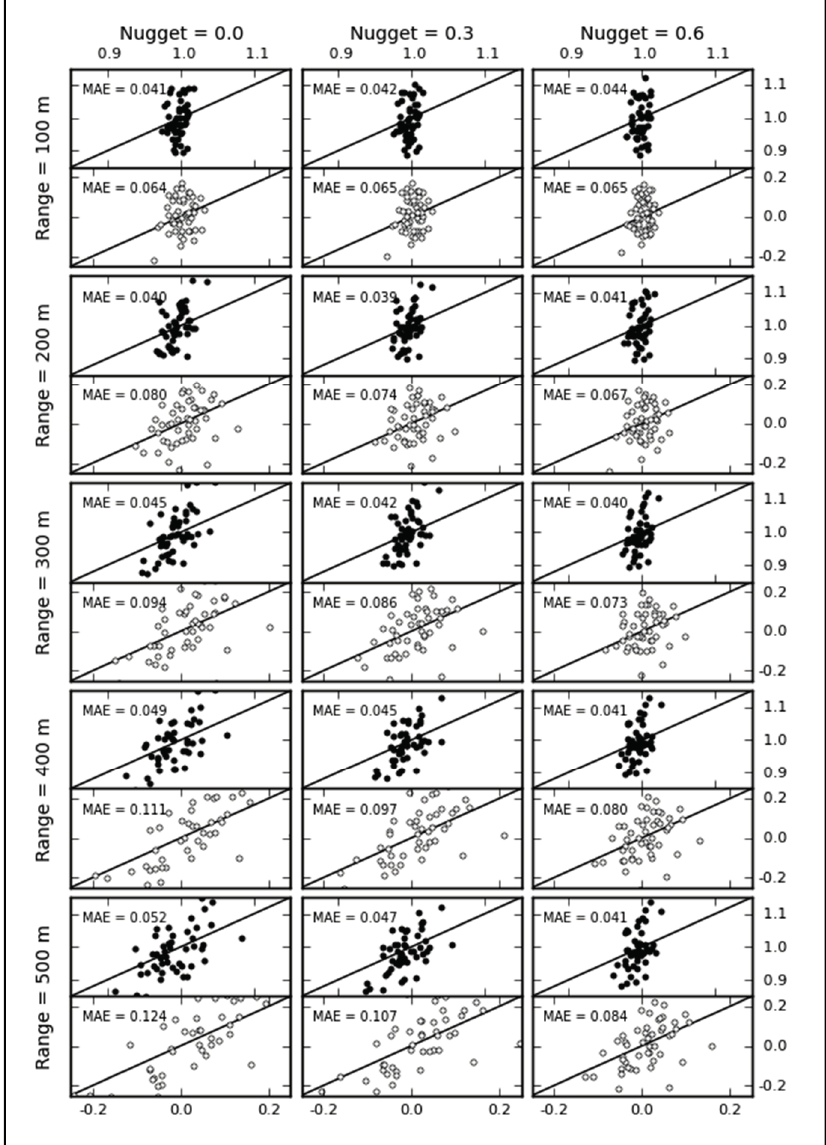
Figure 7. Scatter diagrams of the means (circles) and standard deviations (black dots). The Y - and X -axes represent the samples and the population, respectively.